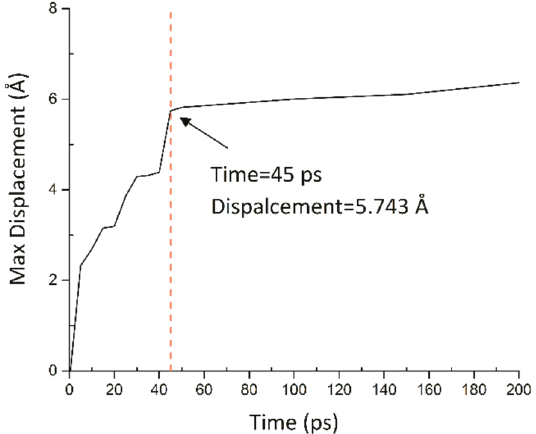
Figure 9. Radial displacement distribution of Fe nanoparticle at 200 ps.